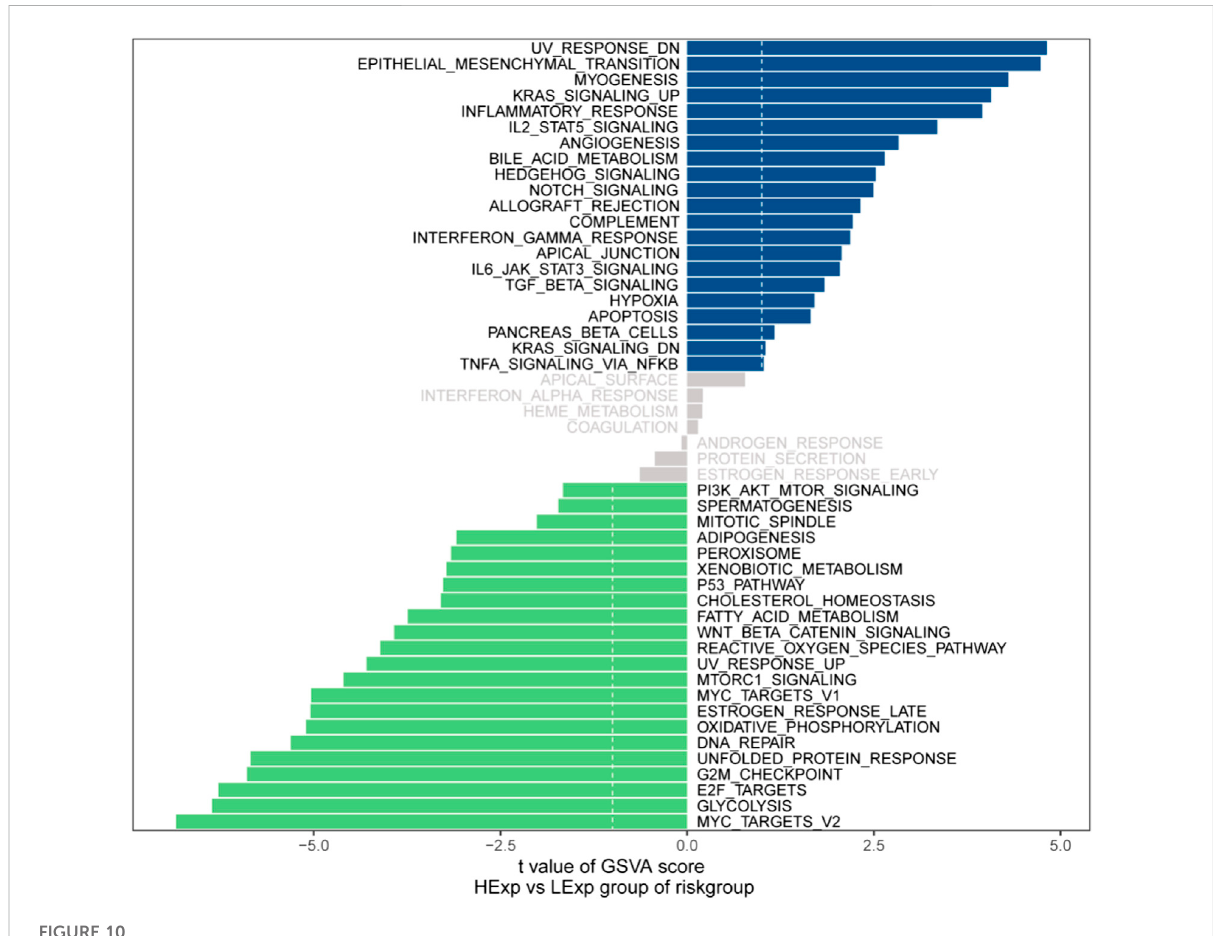
FIGURE 10 Differences in GSVA enrichment among apoptosis risk score